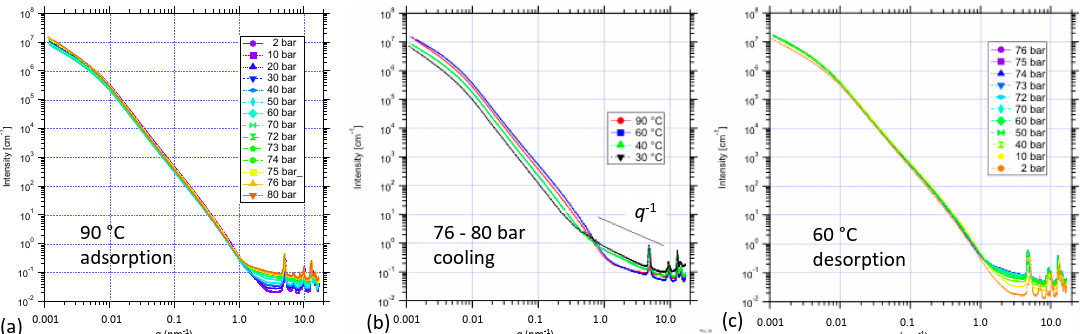
Figure 3. Combined USAXS/SAXS data for NiBpene during ( a ) adsorption of CO 2 to 80 bar in the supercritical fluid regime; ( b ) cooling from 90 ◦ C to 30 ◦ C under 76 bar to 80 bar p CO desorption to 2 bar at 60 ◦ C. Uncertainties are represented by the (small) scatter within each dataset.